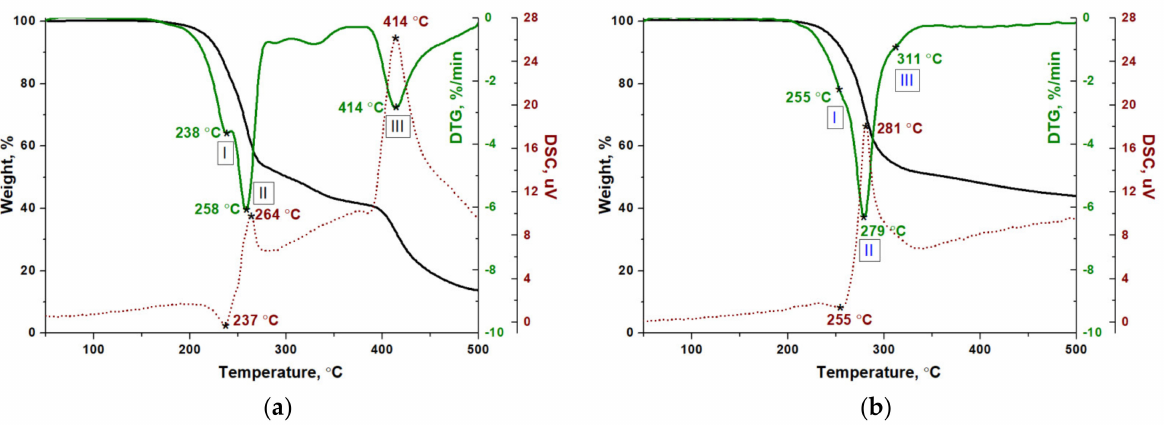
Figure 4. Thermal analysis data for ( a ) [Ni(C 3 H 4 N 2 ) 6 ](NO 3 ) 2 and ( b ) [Ni(C 3 H 4 N 2 ) 6 ](ClO 4 ) 2 com- plexes prepared by melting-assisted solvent-free synthesis (I, II, III—thermolysis stages). The heating rate in air is 5 ◦ C/min.